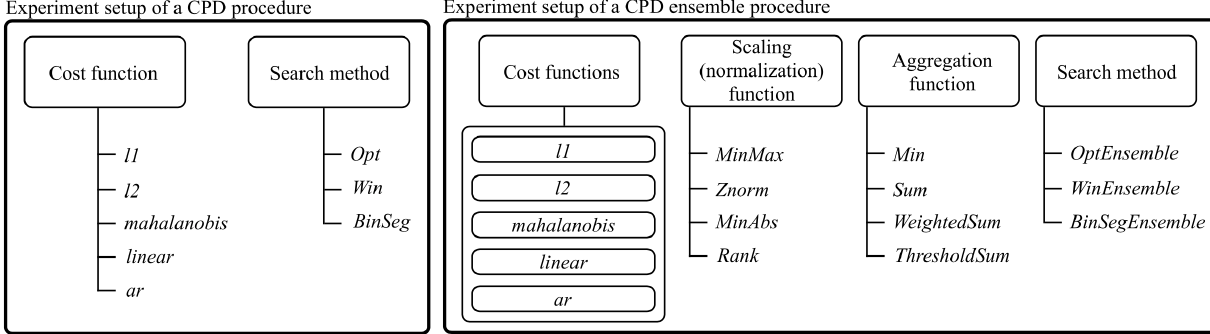
Figure 5. The numerical experiment setup for CPD ensemble and non-ensemble